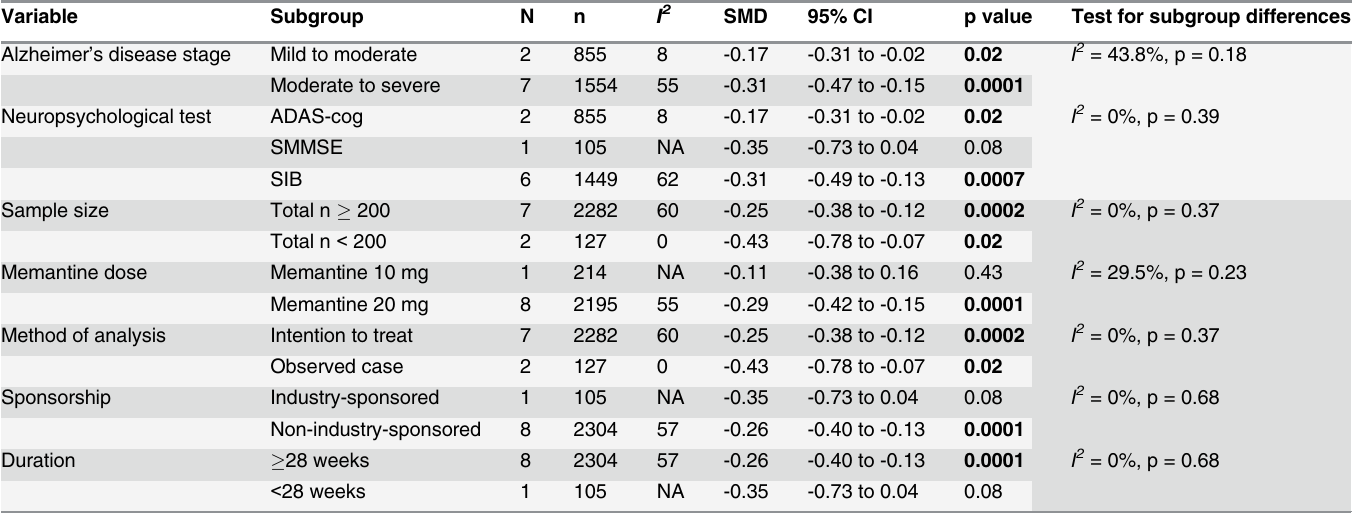
doi:10.1371/journal.pone.0123289.t002